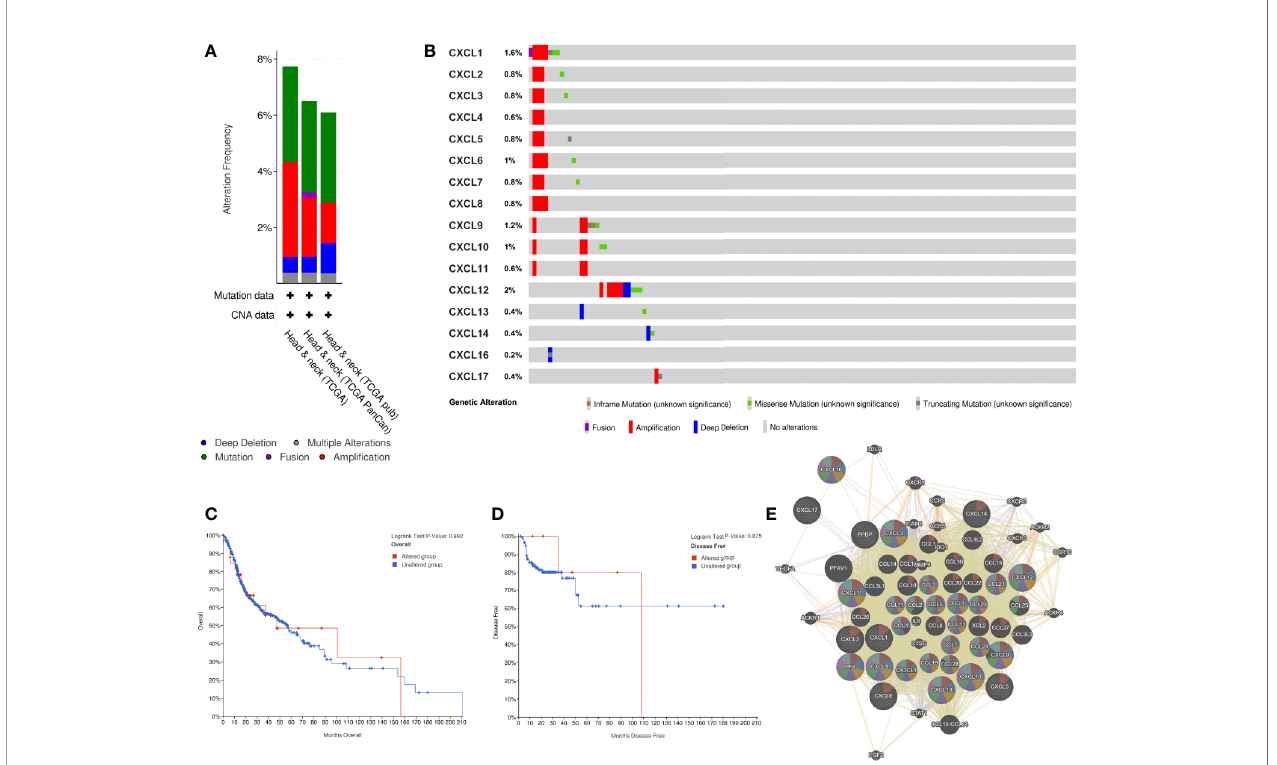
FIGURE 5 | CXC chemokines genetic Alteration and Neighbor Gene Network in patients with HNSCC. (A) Summary of alterations in CXC-chemokines members. (B) OncoPrint visual summary of alteration on a query CXC-chemokines. (C, D) Kaplan-Meier plots comparing OS/DFS in case with/without CXC chemokines member gene alteration. (E) Gene-gene interaction network among CXC chemokines members and 50 most frequently altered neighboring genes.